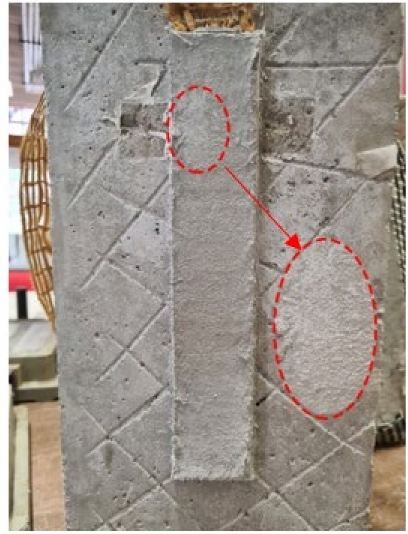
Figure 7. Visual inspection on specimen DS-PBO-AK-1L-2.